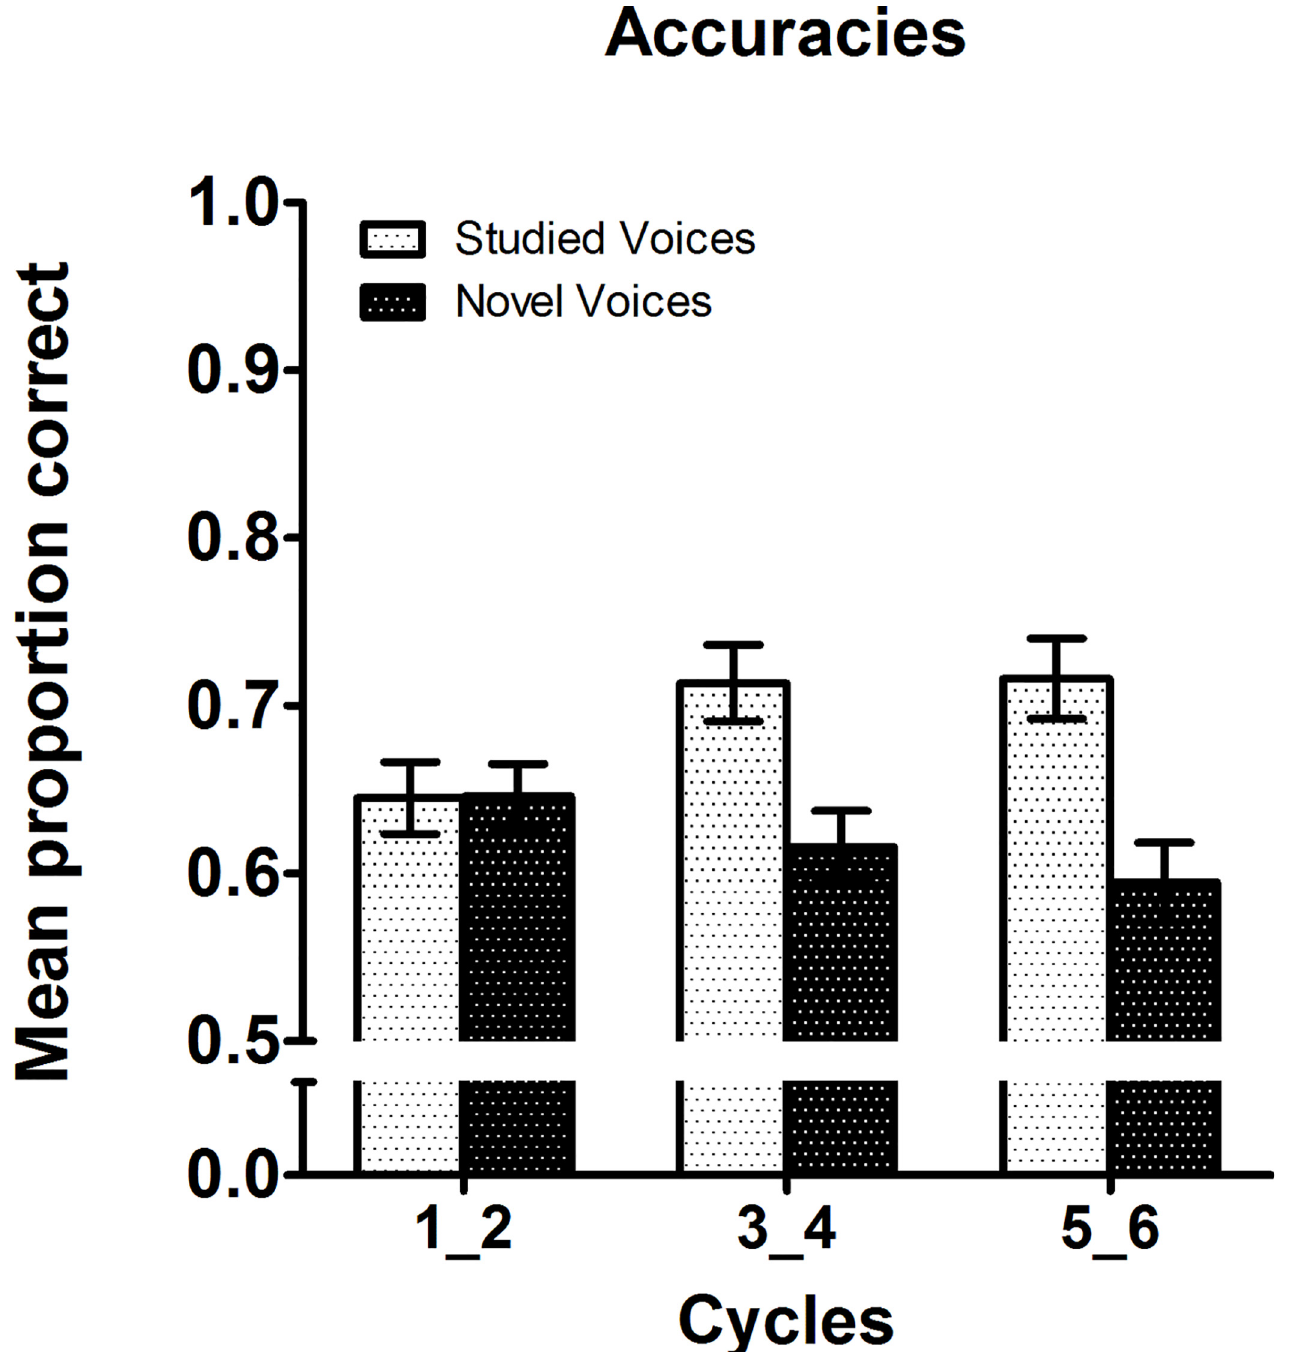
Fig 3. Mean proportion of correct responses to studied vs. novel voices depicted for pairs of consecutive study-test cycles. Note that data are collapsed across learning modality (FV and V) and animation mode (static [Exp. 1] and dynamic [Exp. 2]). Error bars are SEM.